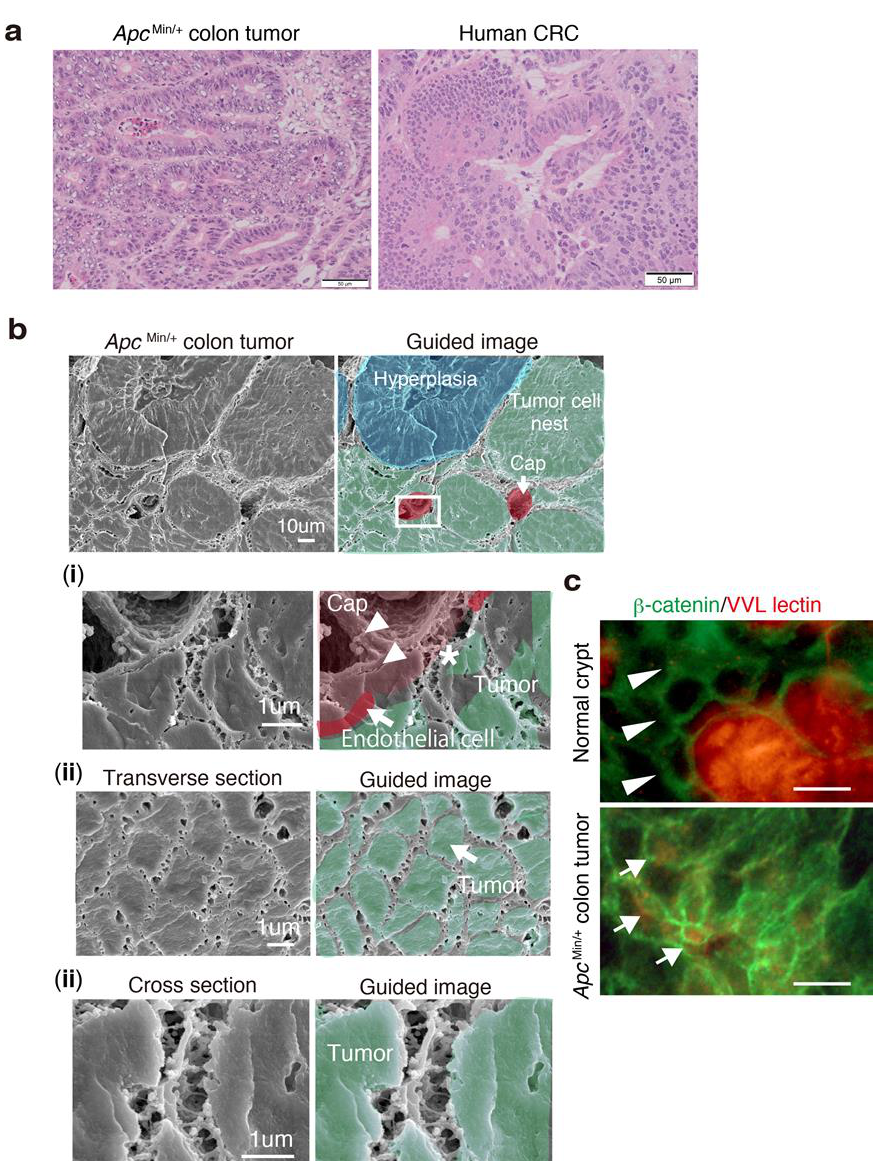
Figure 6. Murine colon cancer phenocopies the 3D network structure in human CRC tissues. ( a ) Representative hematoxylin and eosin (HE) images of frozen sections of Apc Min /+ colon tumor (left) and human colorectal cancer (right). Older Apc Min/+ mice developed several advanced colon tumors at 30 weeks of age, mimicking human adenocarcinomas. ( b ) Representative SEM and guided images of a colon tumor in an Apc Min/+ mouse at 30 weeks of age. ( i ) High magnification of the rectangle in the upper image showing the relationship between a tumor cell nest and a capillary. ( ii ) Transverse and ( iii ) cross sections of Apc Min/+ colon tumors. ( c ) Double IF staining of β-catenin (green) and VVL lectin (red) in the normal crypts and colon tumors of older Apc Min/+ mice. Scale bars indicate 5 μm.